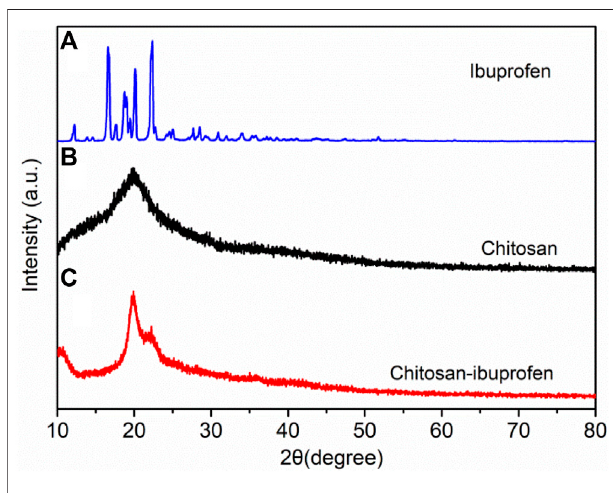
FIGURE5| DSCthermogramsofpureibuprofen (A) ,chitosanpowder (B) ,andchitosan – ibuprofenaerogels (C) ;TGAthermogramsofpureibuprofen (D) ,chitosan powder (E) , and chitosan – ibuprofen aerogels (F) .